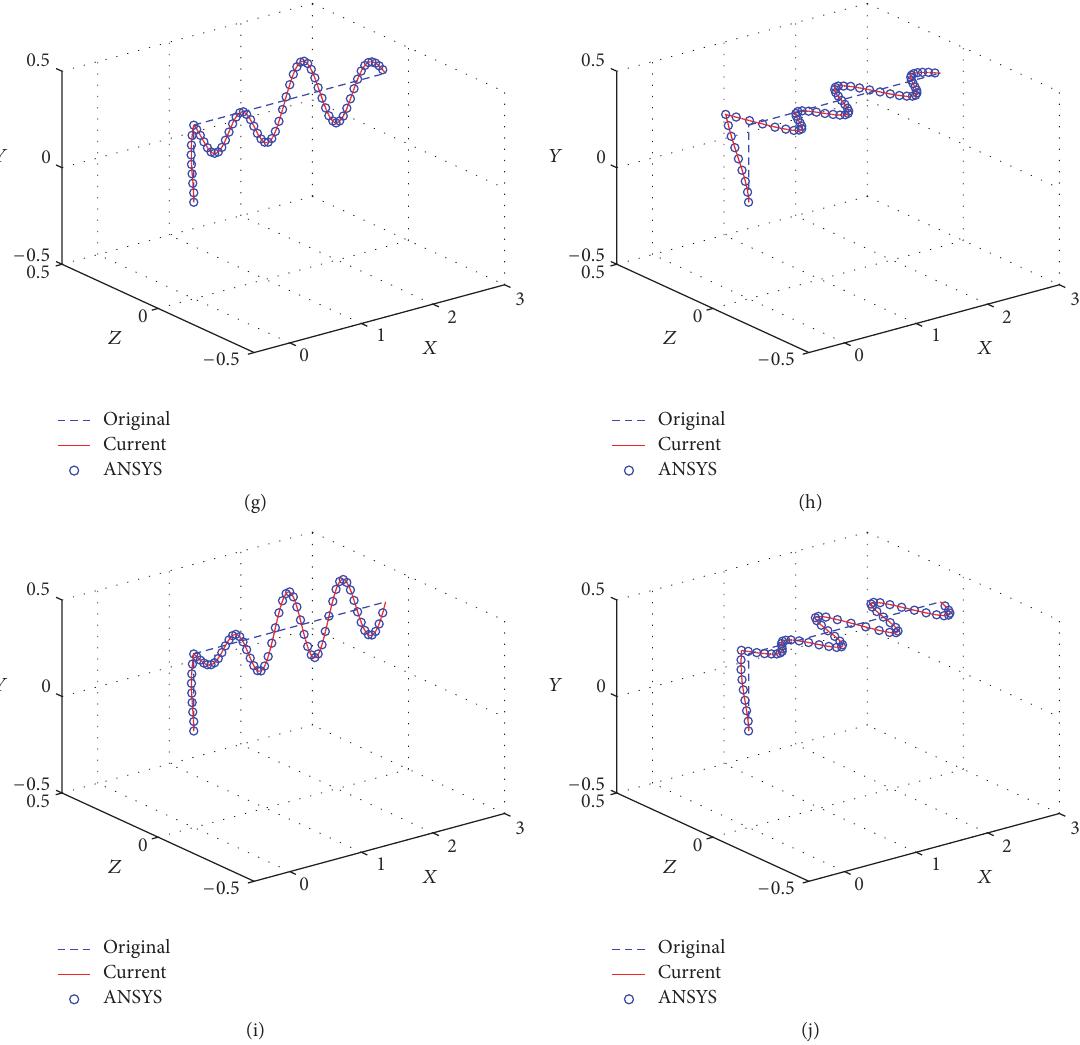
Figure 9: The first ten modes for the shafting: (a) the first mode, (b) the second mode, (c) the third mode, (d) the fourth mode, (e) the fifth mode, (f) the sixth mode, (g) the seventh mode, (h) the eighth mode, (i) the ninth mode, and (j) the tenth